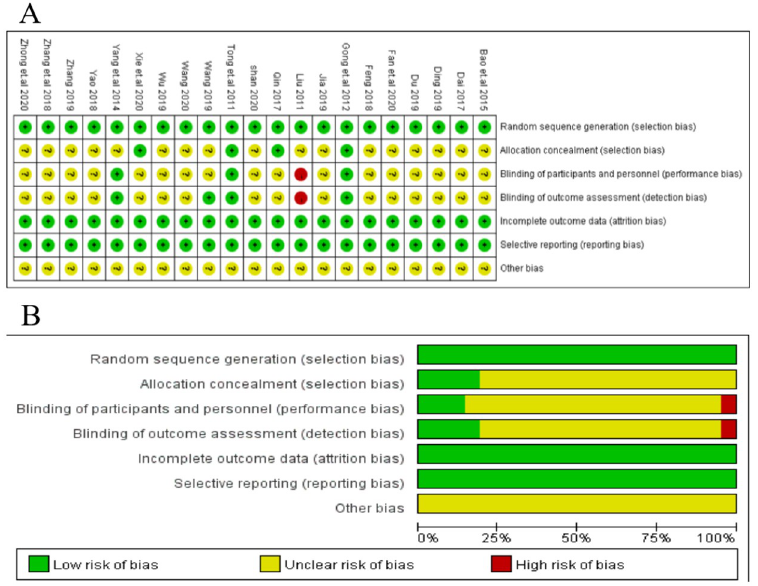
Fig 2. Risk of bias evaluation. (a) Risk of bias graph for each study included; (b) Risk of bias graph for all studies included.